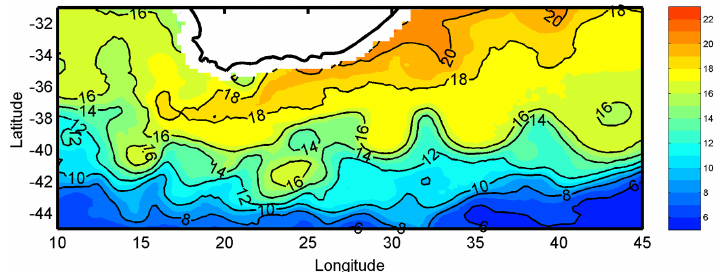
Figure 1. Mean SST ( ◦ C) in August 2003 for the region south of Africa, estimated with the Advanced Microwave Scanning Radiometer (AMSR-E) onboard the satellite Aqua. Two warm eddies with temperatures of about 16–17 ◦ C can be seen centred on 40 ◦ S, 15 ◦ E and 42 ◦ S, 24 ◦ E. They create a strong SST gradient with the surrounding ocean. Cold eddies are visible at 38 ◦ S, 43 ◦ E and at 39 ◦ S , 25 ◦ E and an eddy is being shed from the Agulhas Current at 37 ◦ S, 17 ◦ E. The meanders of the Agulhas Return Current are also evident from 25 ◦ E eastward along 39 ◦